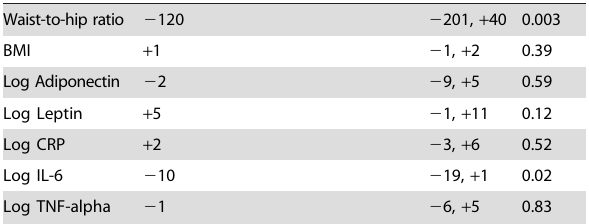
Table 4. Effect of waist-to-hip ratio on change in telomere length (as a continuous variable) after adjustment for body mass index, adipokines, and inflammatory